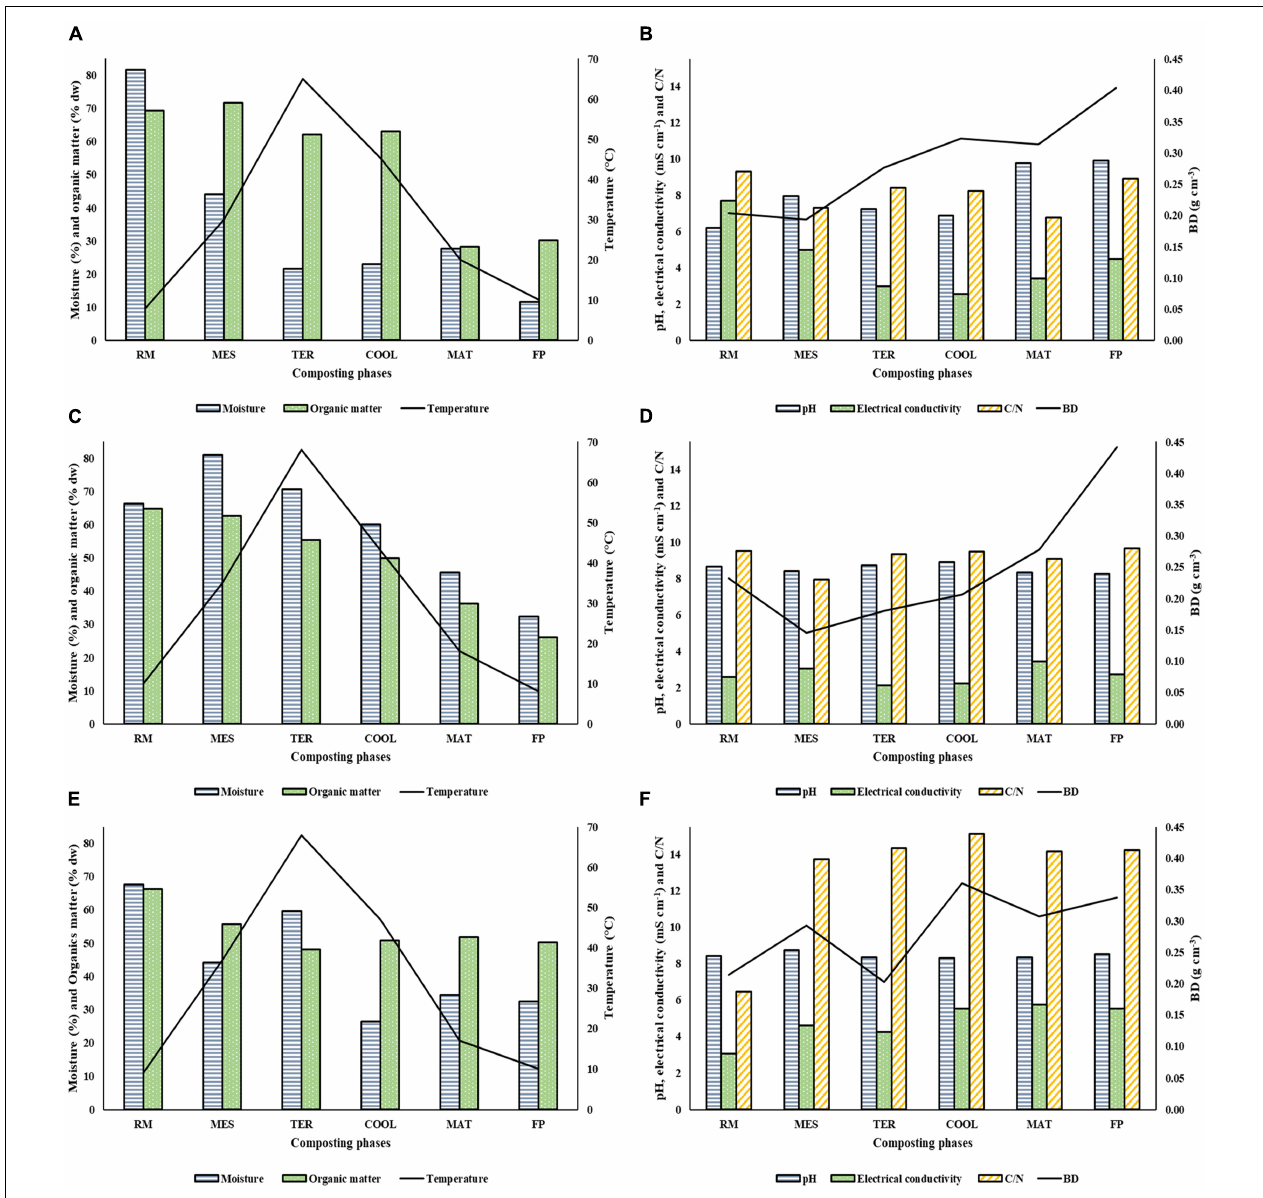
FIGURE 1 | Control parameters analysis. Moisture (%), organic matter (% dw), and temperature ( ◦ C) are in Panels (A,C,E) ; pH, electrical conductivity (mS cm − 1 ), C/N, and BD (bulk density) (g cm − 3 ) are in Panels (B,D,F) . Panels (A,B) represent SS1; Panels (C,D) represent SS2; Panels (E,F) represent SS3. SS1, SS2, and SS3 represent each of the sampled sewage sludge composting